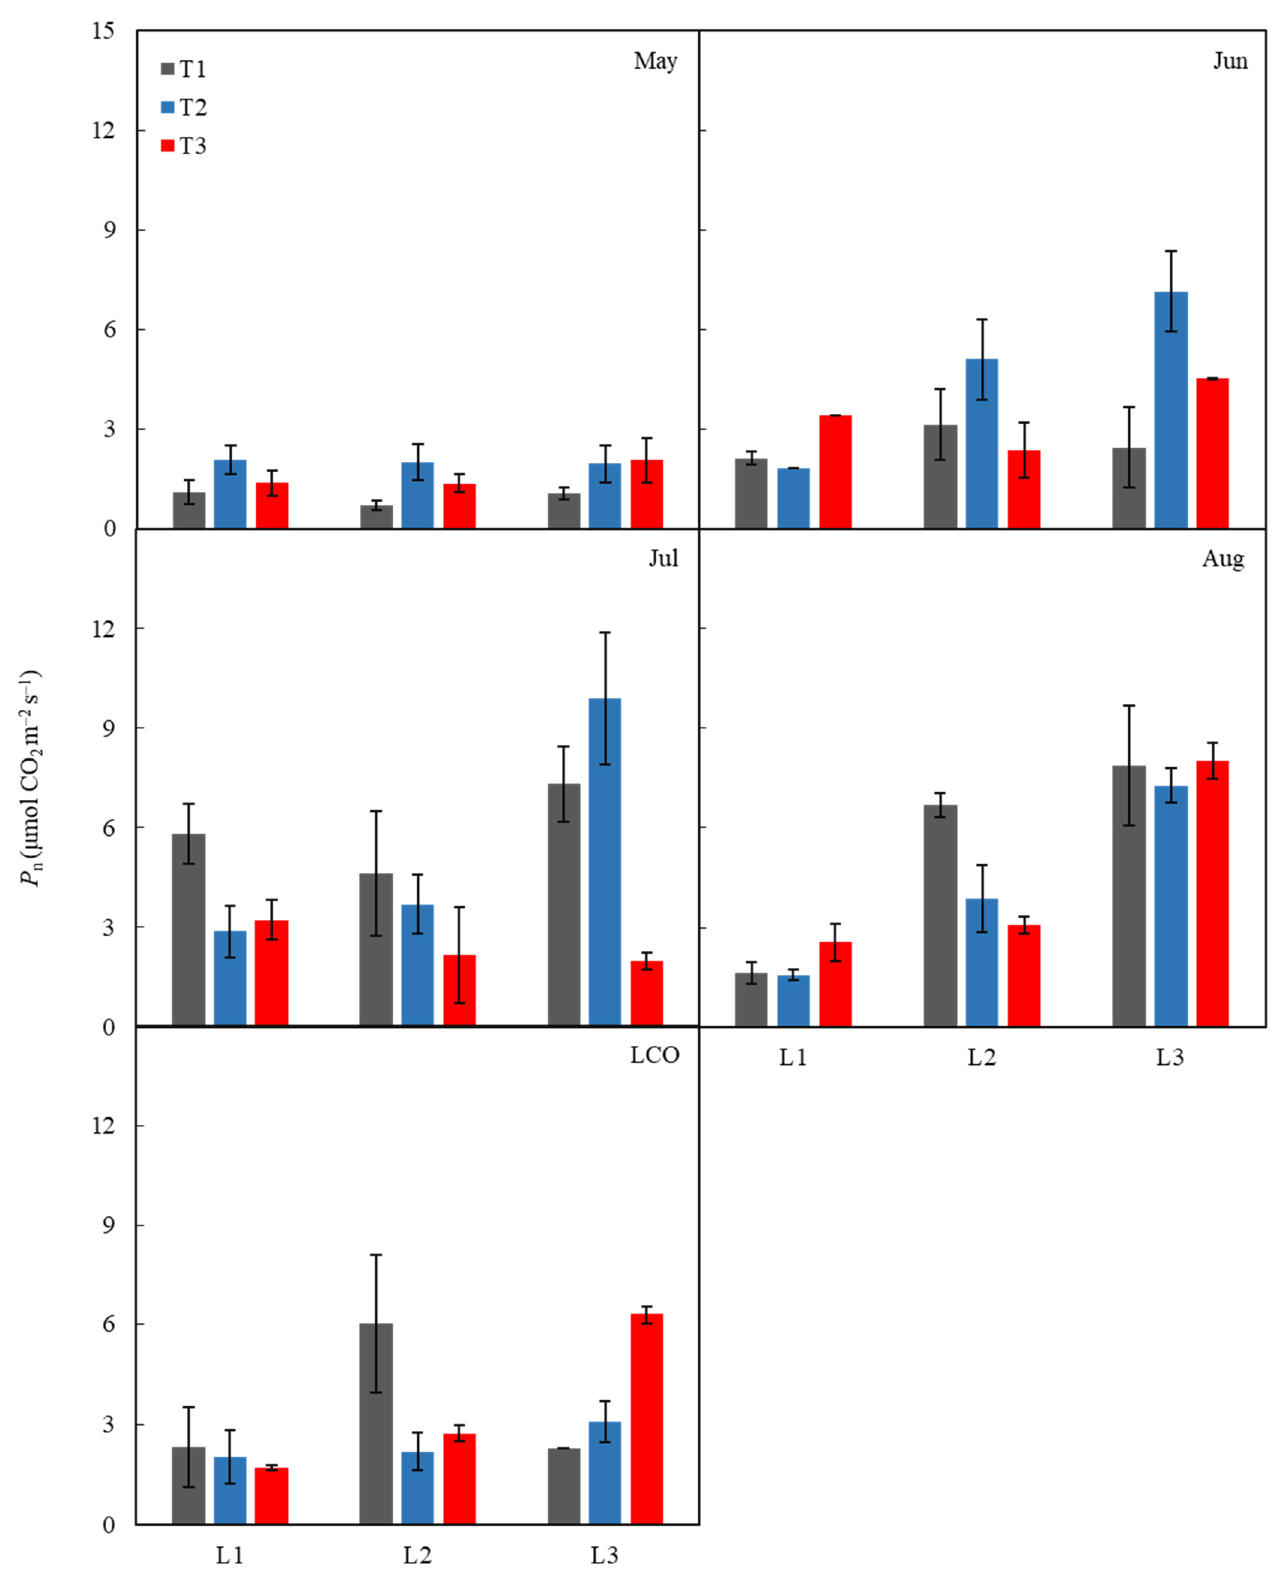
Figure 3. Changes in the net CO 2 assimilation rate ( P n ) of different periods under the temperature and photoperiod treatments. Error bars represent means ± SE ( n = 3). T1 represents control; T2 represents 1.5 °C warming; T3 represents 2.0 °C warming; L1 represents 18 h photoperiod (long photoperiod), L2 represents 14 h photoperiod (control), and L3 represents 10 h photoperiod (short photoperiod).